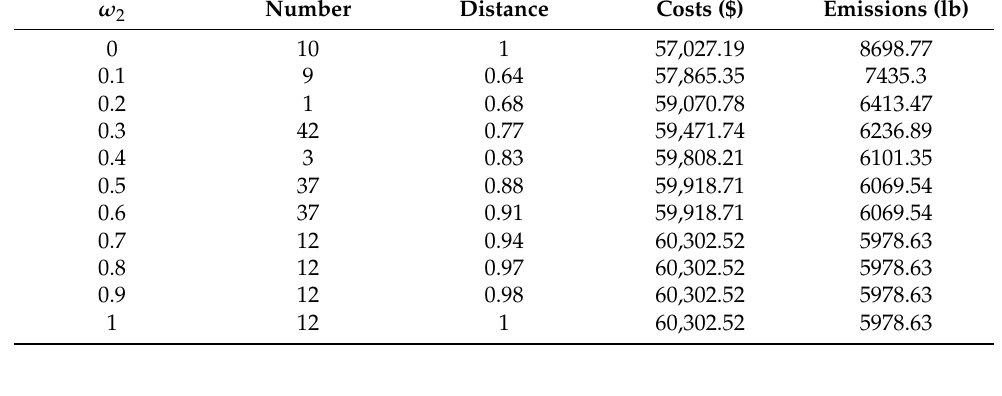
Table 5. Satisfying solutions combined with corresponding costs and emissions ( α = 0.05).